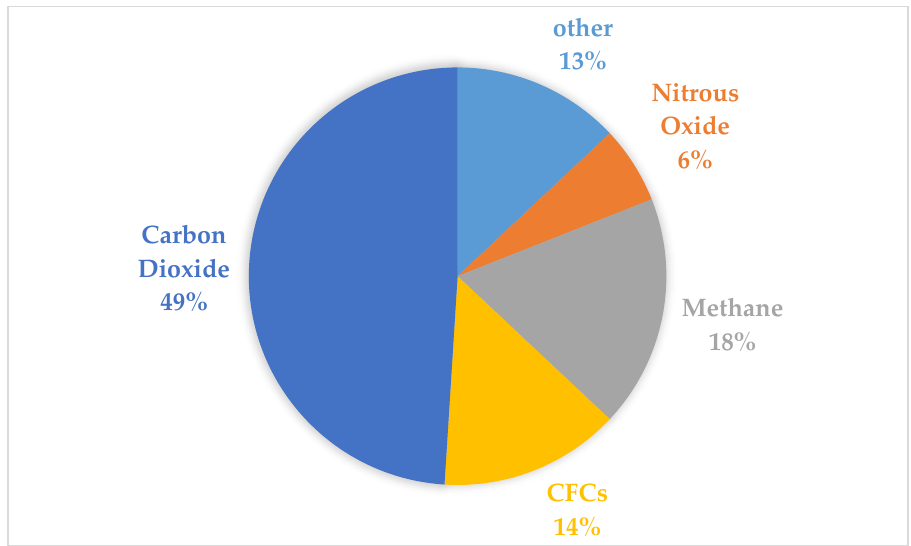
Figure 1. Human contributions to the greenhouse effect.